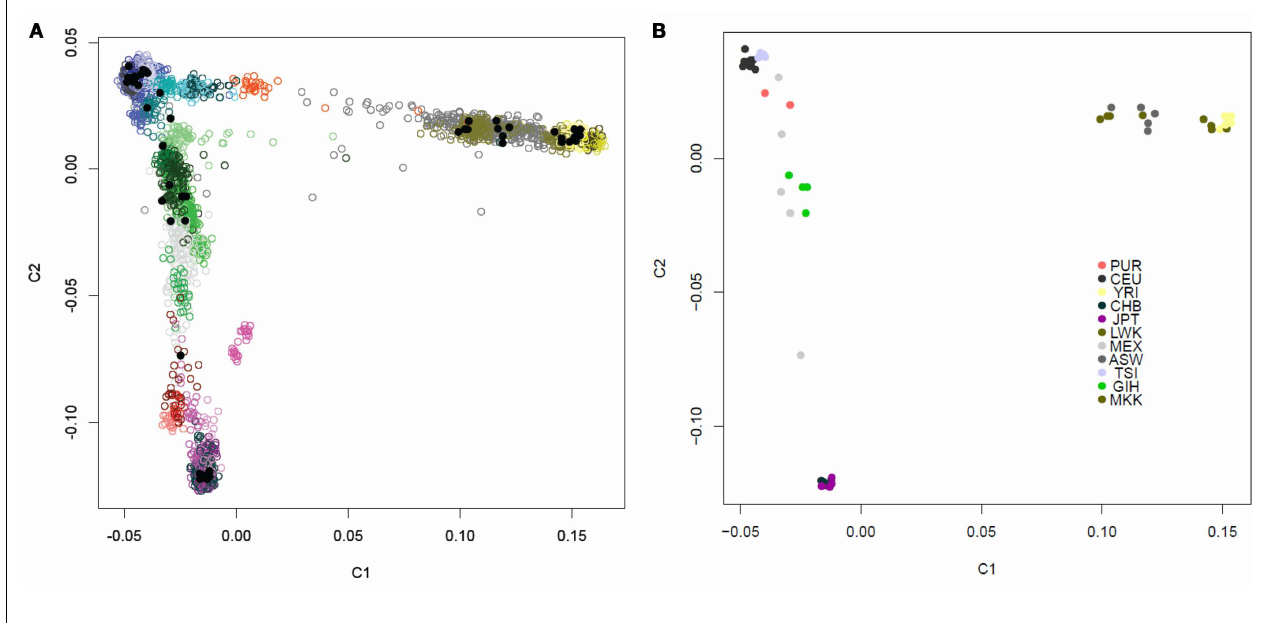
(Blue, Europeans;Yellow,Yorubans; Purple, East Asians; Red: Native Americans; Green: Central Asians; Grey: African Americans). (B) Multidimensional scaling plot of the similarity of the content of 54 individuals with complete individual genomes without the overlay of other individuals. Color coding for these 54 individuals based on their known ancestries is given in the